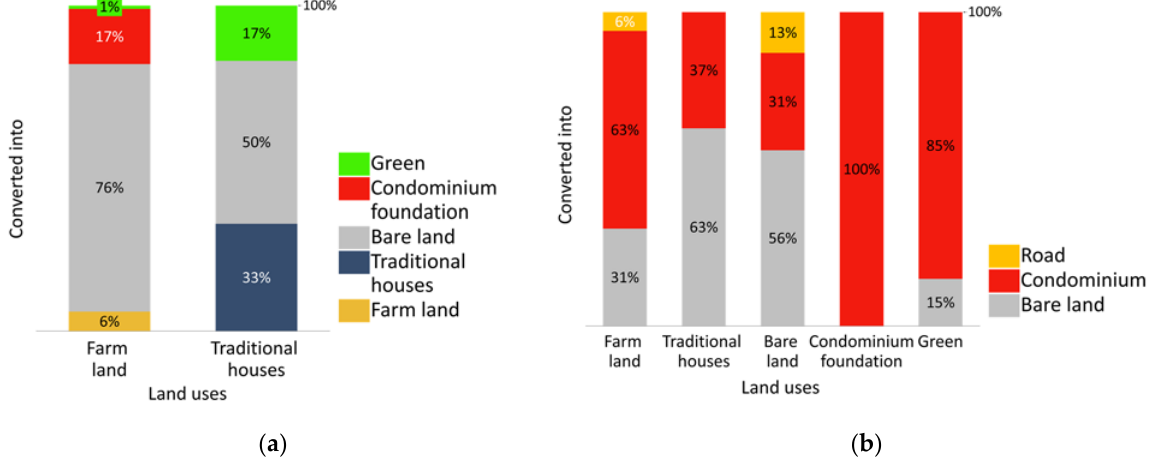
Figure 7. ( a ) The land use conversion matrix between 2002 and 2012 in the urban fringe neighborhood. ( b ) The land use conversion matrix between 2012 and 2020 in the urban fringe neighborhood.